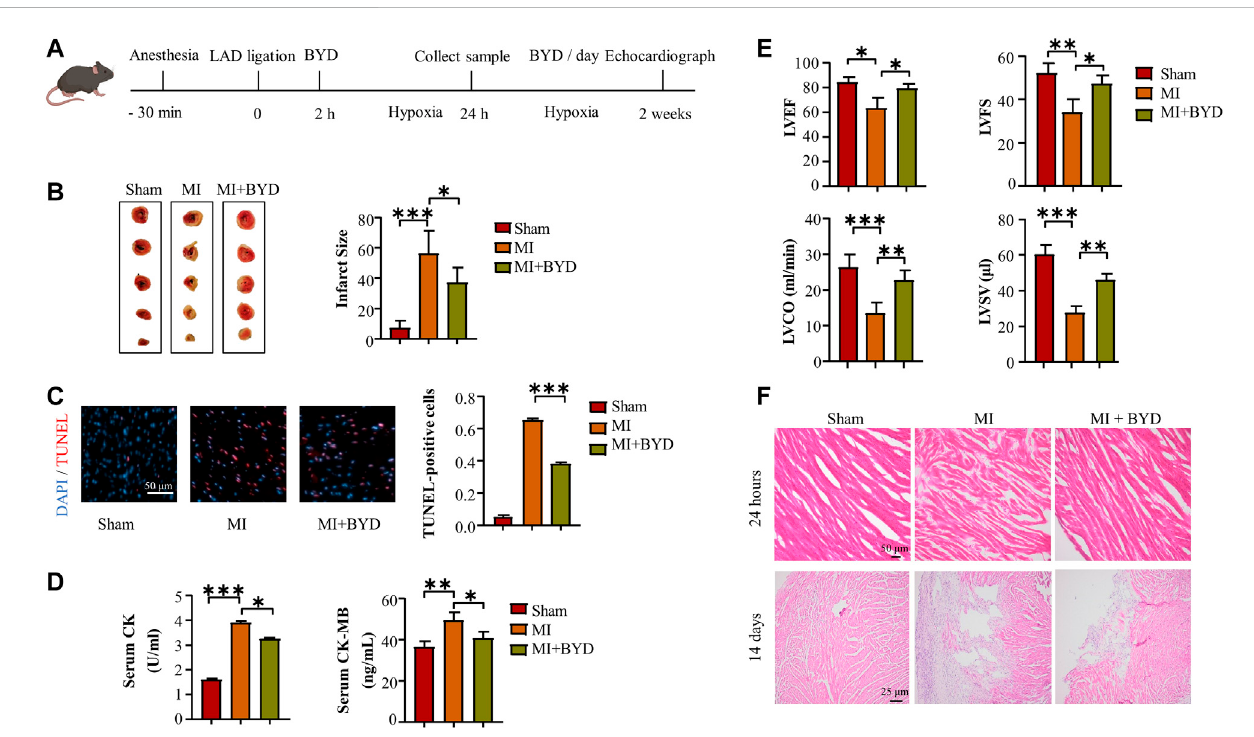
FIGURE 2 The in vivo cardioprotective effects of BYDE against MI. (A) Experimental procedure. (B) Infarct size in MI mice. (C) TUNEL Assay for DNA damage. Representative images from TUNEL staining of the myocardial layers in the risky area. Ampli fi cation, 400×; Scale bar, 50 µm. (D) The levels of serum CK and CK-MB. (E) Echocardiographic examination of heart functions. At 2 weeks after MI, M-mode echocardiography was recorded for animals in each group and calculatedforleftventricularejectionfraction(LVEF)andleftventricularfractionalshortening(LVFS).Dopplerechocardiography.At2weeksafterMI,PW Dopplerechocardiographywasrecordedforanimalsineachgroupandcalculatedforleftventricularcardiacoutput(LVCO)andleftventricularstrokevolume (LVSV). (F) Representative images from H&E staining of the myocardial layers in the risk area after 24 h ischemia challenge (top panel) and 14 days (bottom panel). Scale bar, 50 μ m (top panel) and 25 μ m (bottom panel). Data were expressed as mean ± S.D. (n = 6). * p < .05, ** p < .01, *** p <